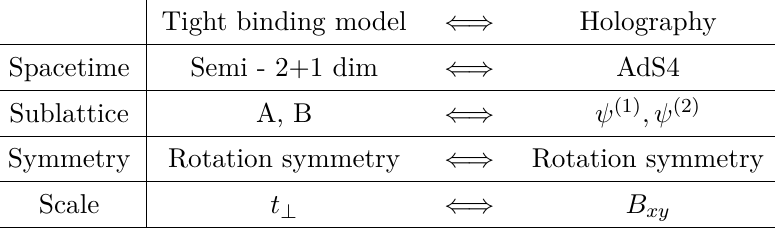
Table 1 . Correspondence of two